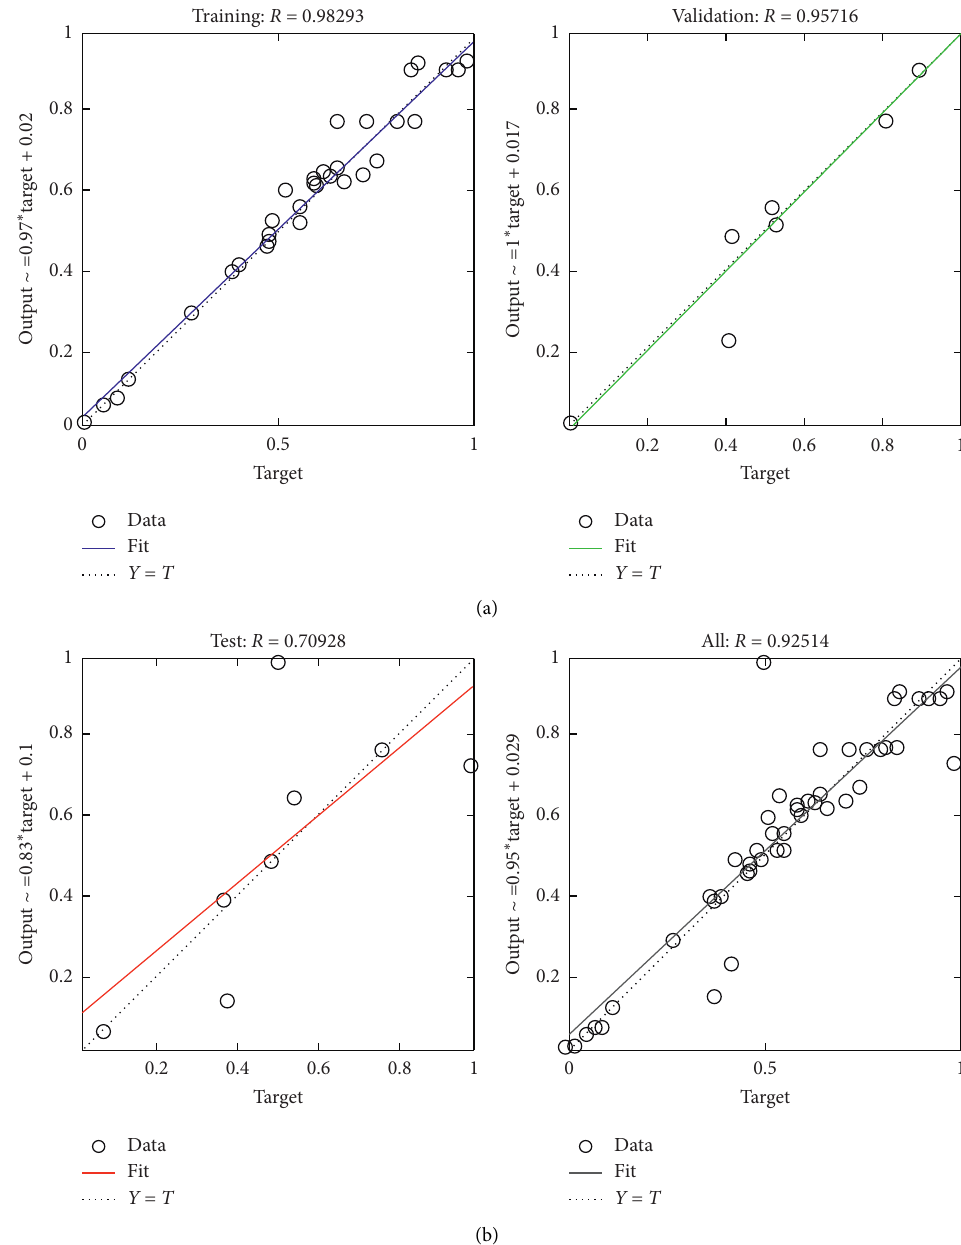
Figure 6: Simulation results of